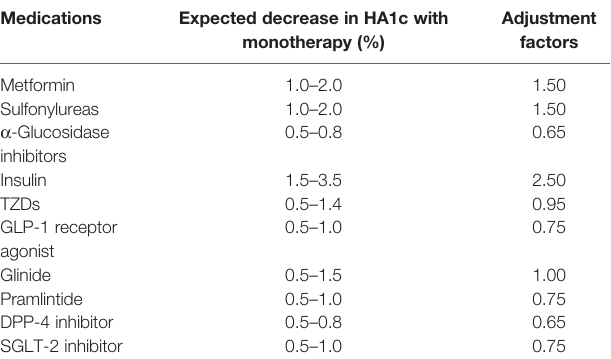
TABLE 1 | Summary of adjustment factor for medications.